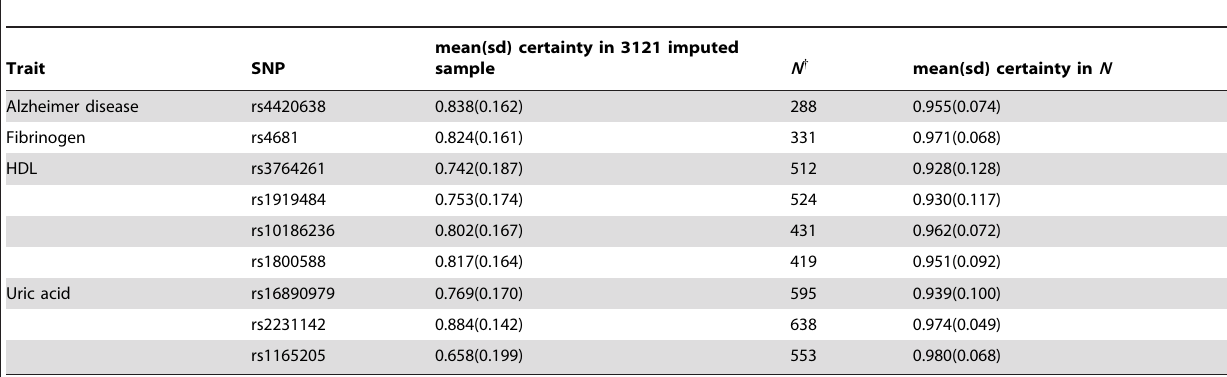
Table 2. Mean imputation certainty of the top SNPs in the entire 3121 imputed sample and in the person-specific certainty . 0.5, SNP-specific certainty . 0.6 and phenotyped